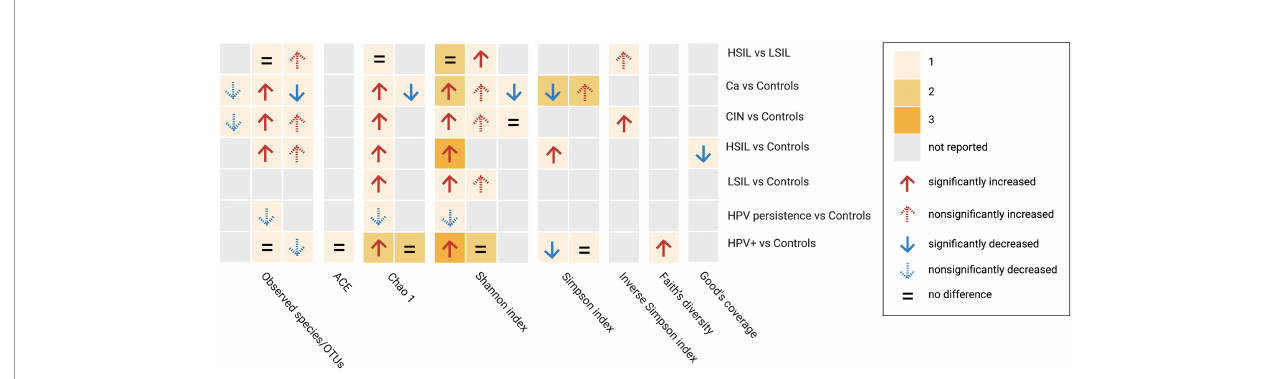
FIGURE 2 | Alpha diversity assessments reported by studies between subgroup and controls based on different metrics. Cells are colored based on the number of assessments. HPV+, HPV-positive women; LSIL, low-grade squamous intraepithelial lesions; HSIL; high-grade squamous intraepithelial lesions; CIN, cervical intraepithelial neoplasia; Ca, cervical cancer; OTUs, operational